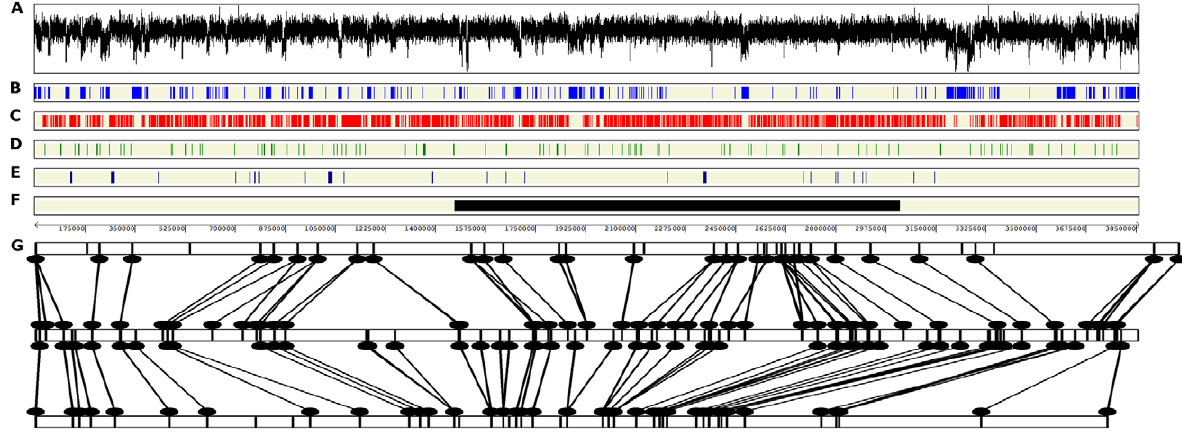
Figure 1. Features of chromosome 2 of Mycosphaerellagraminicola and alignment to genetic linkage maps. A, Plot of GC content. Areas of low GC usually correspond to regions of repetitive DNA. B, Repetitive regions of the M. graminicola genome. C, Single-copy (red) regions of the M. graminicola genome. D, Locations of genes for proteins containing signal peptides. E, Locations of homologs involved in pathogenicity or virulence that have been experimentally verified in species pathogenic to plant, animal or human hosts. F, Approximate locations of quantitative trait loci (QTL) for pathogenicity to wheat. G, Alignments between the genomic sequence and two genetic linkage maps of crosses involving isolate IPO323. Top half, Genetic linkage map of the cross between IPO323 and the Algerian durum wheat isolate IPO95052. Bottom half, Genetic linkage map of the cross between bread wheat isolates IPO323 and IPO94269. The physical map represented by the genomic sequence is in the center. Lines connect mapped genetic markers in each linkage map to their corresponding locations on the physical map based on the sequences of the marker loci. Exceptions to the almost perfect alignment between the three maps are indicated by crossed lines, most likely due to occasional incorrect scorings of the marker alleles. Chromosome 2 was used for this illustration because no QTL mapped to chromosome 1.